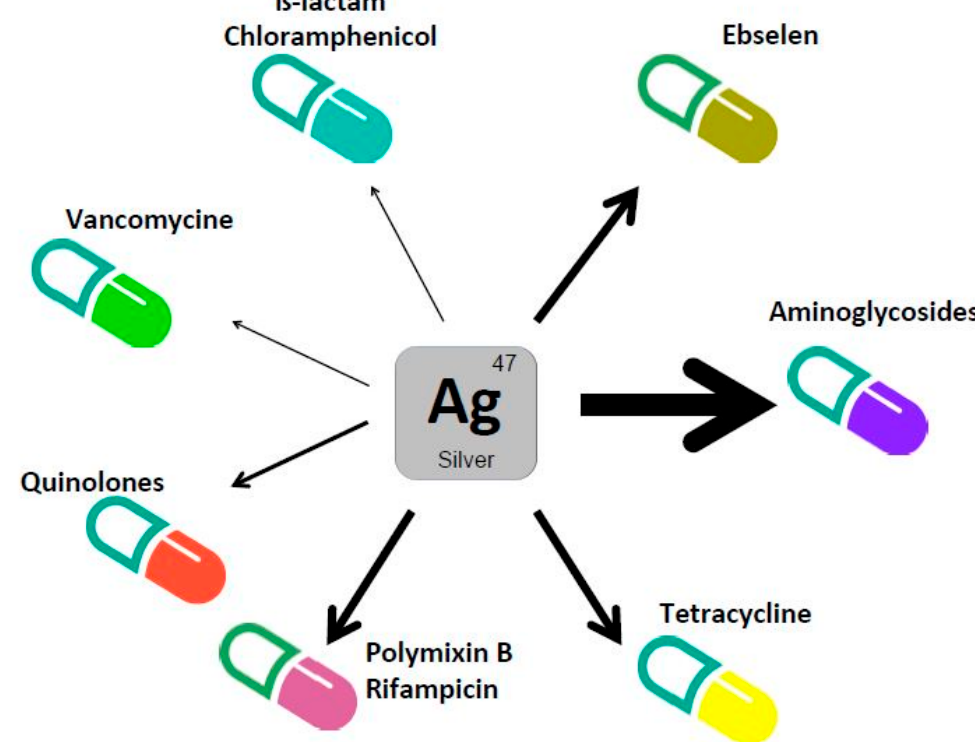
Figure 3. Silver potentiates antibiotics toxicity. The capacity of silver ions to enhance the toxicity of antibiotics from different family is represented. The size of the arrows line reflects the extent of the synergistic effect.